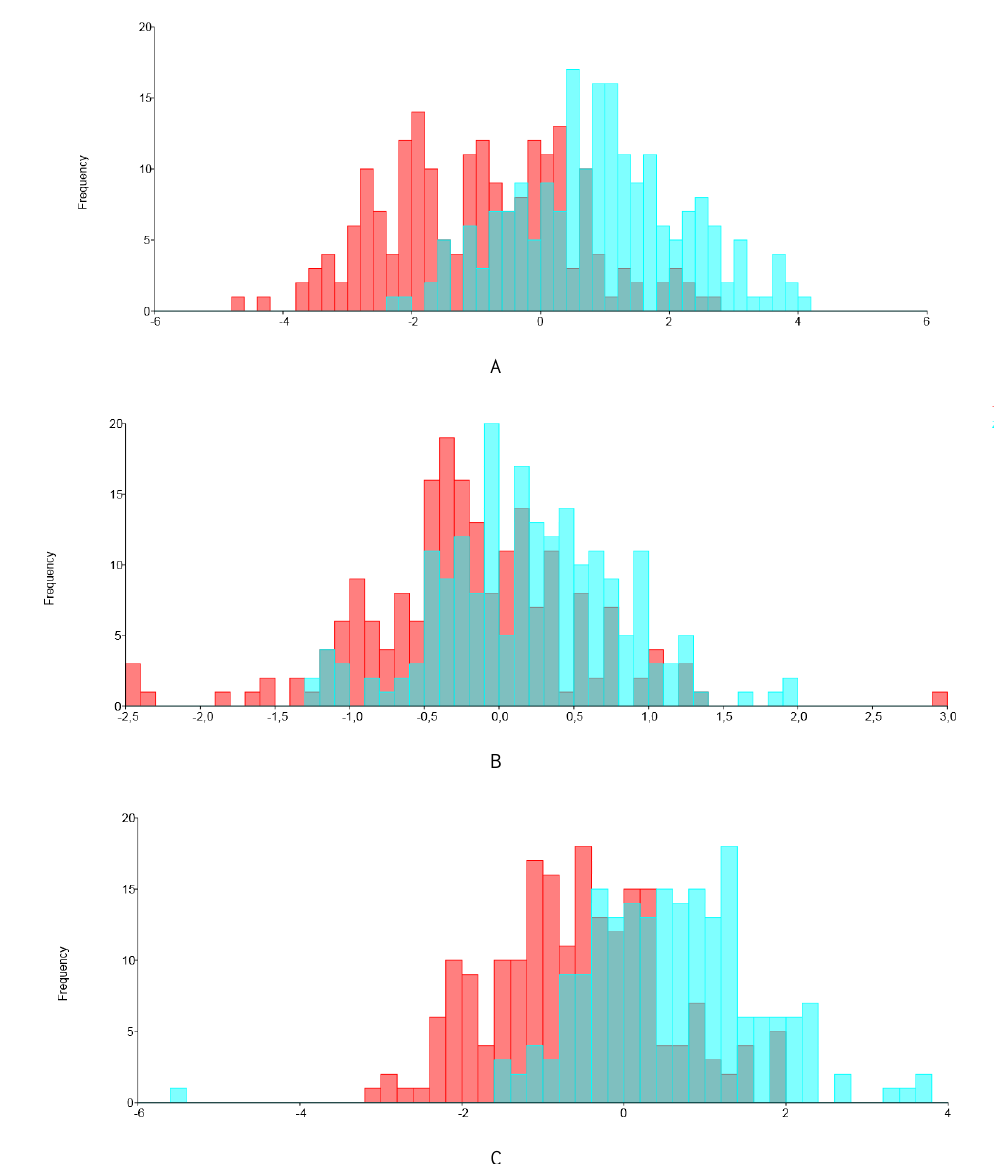
Figure 5. Discriminant analysis of three populations (matrices of asymmetry). A : pop. №1 and №10. B : №8 and №1. C : №8 and №10. Pop. №1 is clear FA, pop. №№ 8, 10 are mixture FA+DA. Procrustes distance was highest between pop№1 and pop№10 (Figure 5A), and between pop№8-10 shorter and pop№1-8 shortest (Figure 5C), correspondingly: 0.019 and 0.011; p (param.) < 0.001(Table 4). Table 4. Procrustes distances and T square for three populations (№1, 8 and 10) Procrustes distance